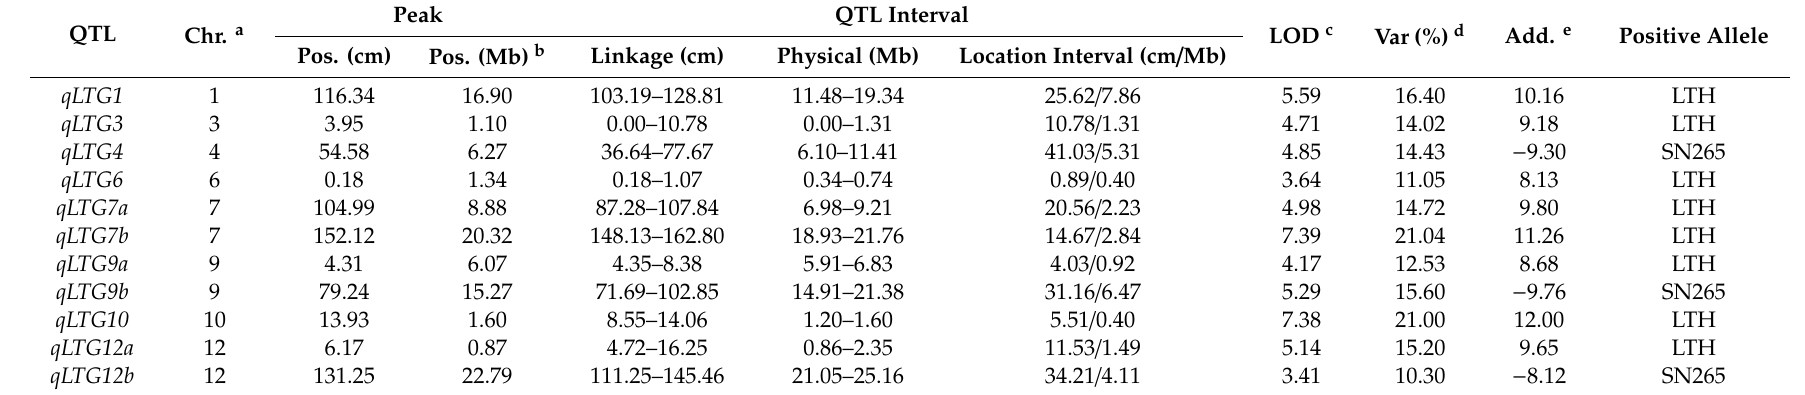
Table 2. Characteristics of the high-density genetic map derived from a cross between LTH and